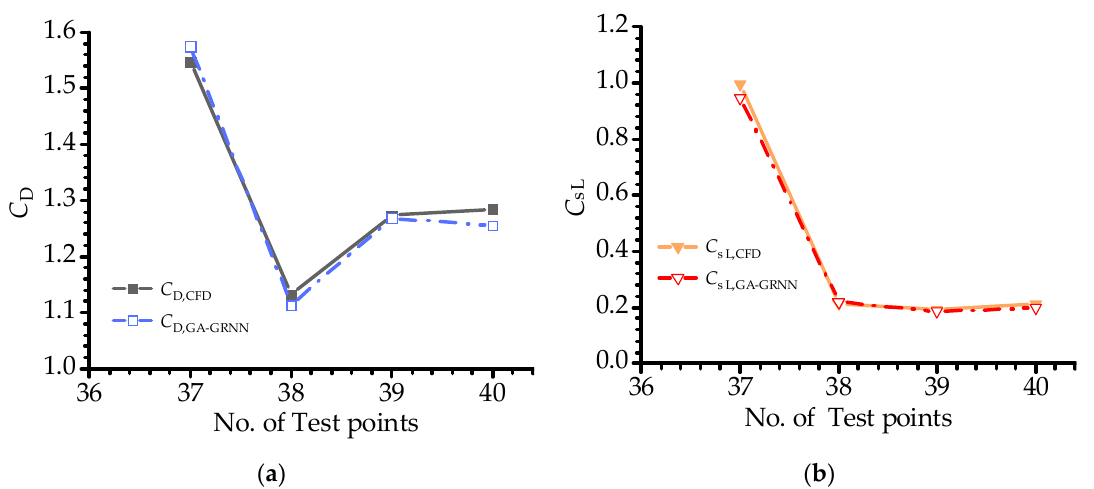
Figure 6. The aerodynamic force coefficients of the test sample points in terms of ( a ) The mean drag coefficient C D and ( b ) The root mean square lift coefficient C σ L .